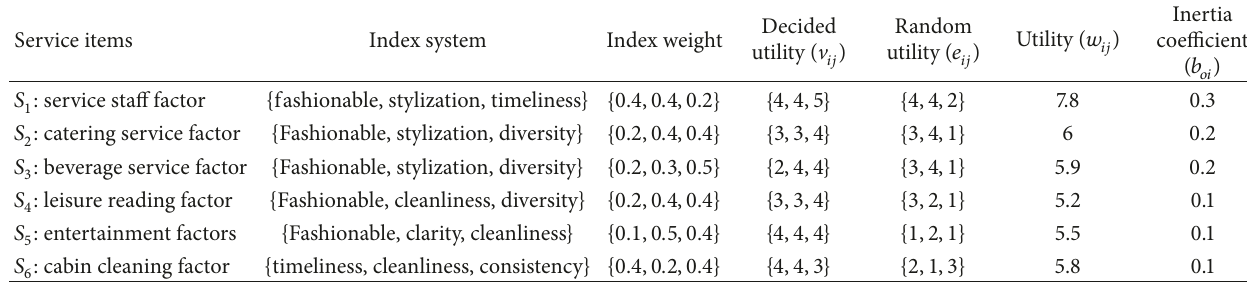
Table 4: Service utility table.